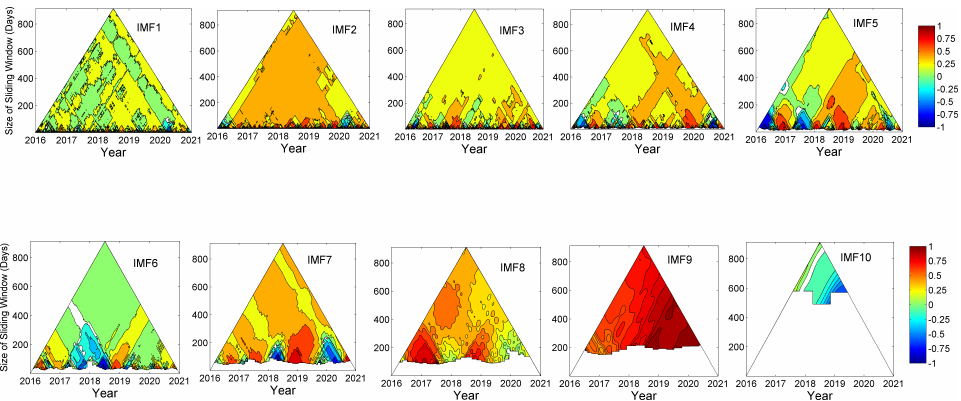
Figure 12. TDIC plots between temperature ( T ) and wind direction ( WD ). The white spaces imply that correlation is not significant at the 5% level.